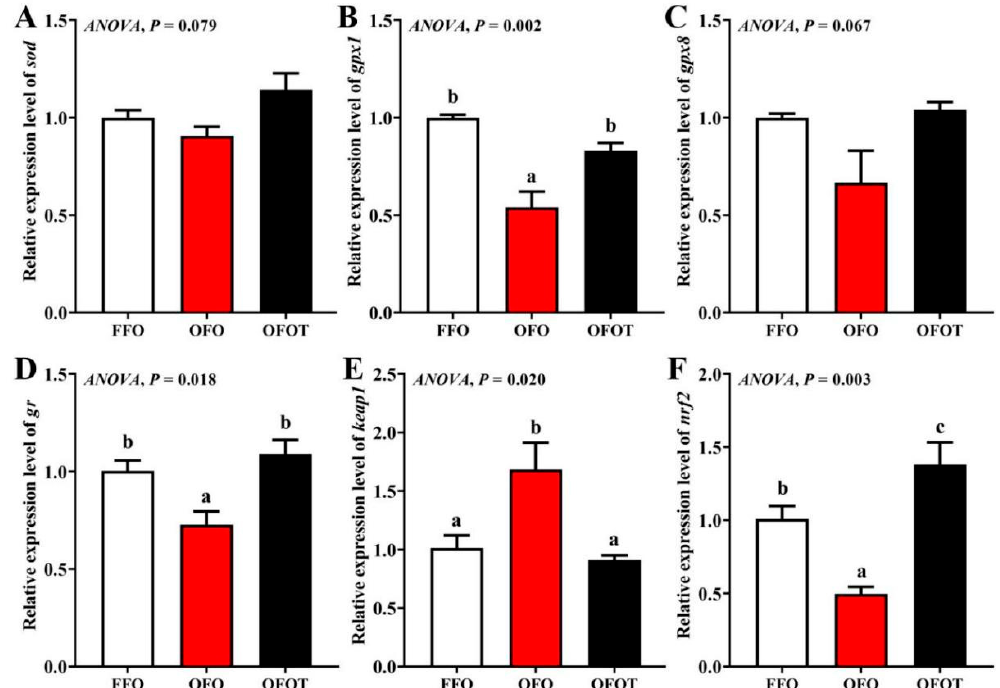
Figure 4. Effects of dietary taurine on liver antioxidant-related genes expression of channel catfish ( Ictalurus punctatus ) fed oxidized-fish-oil diets. ( A ) sod ; ( B ) gpx1 ; ( C ) gpx8 ; ( D ) gr ; ( E ) keap1 ; ( F ) nrf2 . Data indicate the mean values of three replicate cages per treatment (three fish per replicate breeding barrel). Significance was evaluated by one-way ANOVA ( p < 0.05) followed by Duncan’s multiple range tests. Values marked with different letters are significantly different between the treatment groups.